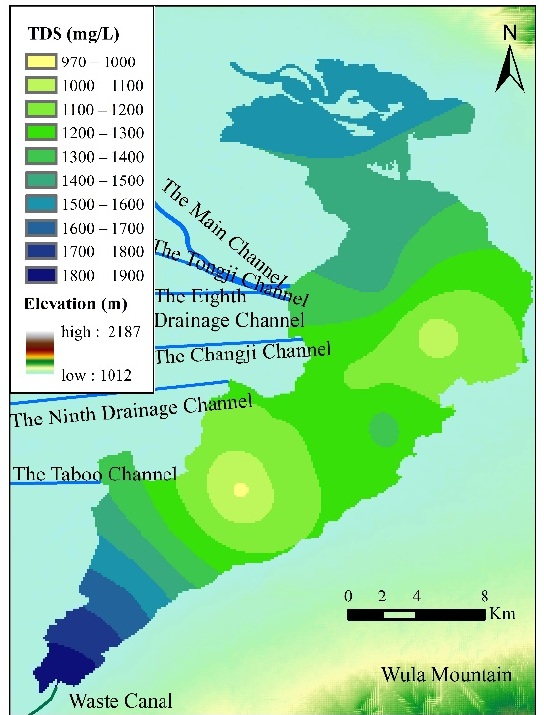
Figure 5. Spatial distribution of TDS in the lake water.